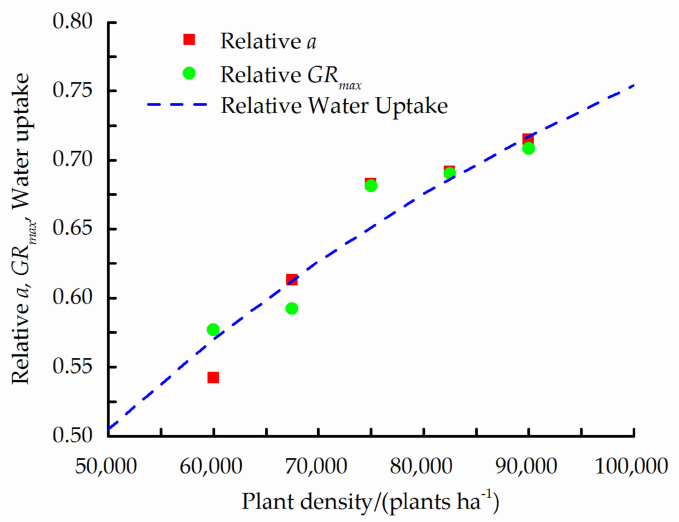
Figure 3. Relative water uptake as function of PD (broken line) fitted to the dependence of the final DMA, a (square markers), and of the maximum growth rate, GR max (circular markers), growth model parameters on the